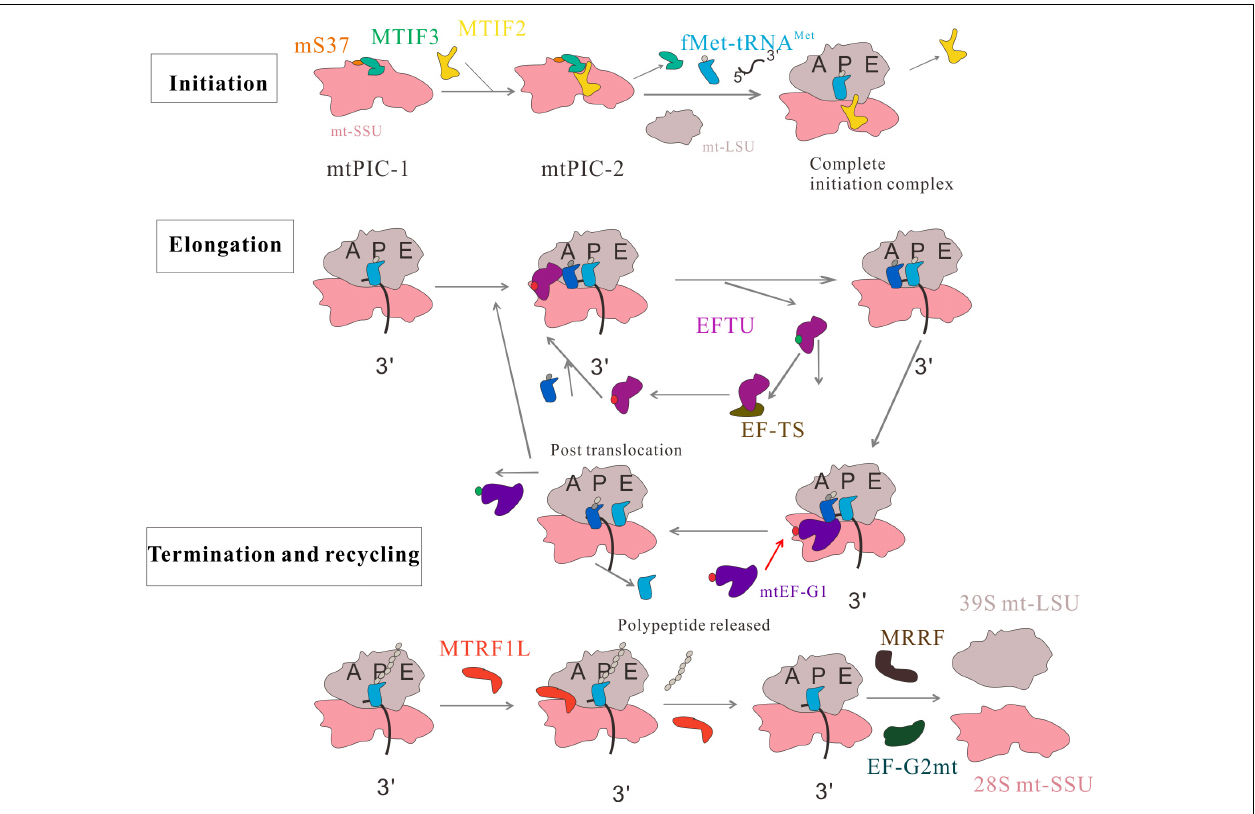
FIGURE 1 | Human mitochondrial translation. The process includes four phases: initiation, elongation, termination, and recycling. In the initiation phase, two distinct pre-initiation assembly steps, termed mitochondrial preinitiation steps 1 and 2 (mtPIC-1, mtPIC-2) are established. In the elongation phase, the aminoacyl-tRNA is transferred to the A site of mitochondrial ribosome by GTP · EFTU, and GTP · EFTU is transformed into GDP · EFTU. EF-TS converts GDP · EFTU to GTP · EFTU. The peptide-tRNA in the P site is transferred from the P site to the A site. mtEF-G1 binds to the ribosome at the A site and promotes translocation of the ribosome along the mRNA by inducing movement of A-tRNAs and P-tRNAs to the P site and E site. The tRNA at the E site leaves the monomer and this cycle continues until the polypeptide is completed and the stop codon appears at the A site. MRRF and EF-G2mt promote the separation of ribosomal subunits; MTIF3 combines with the small mitochondrial ribosomal subunits to prevent the premature reassociation of the large and small